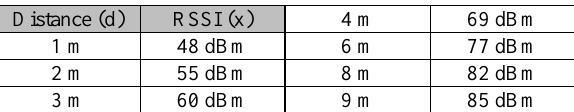
Table 1. Known distance and symmetric RSS for seven lengths